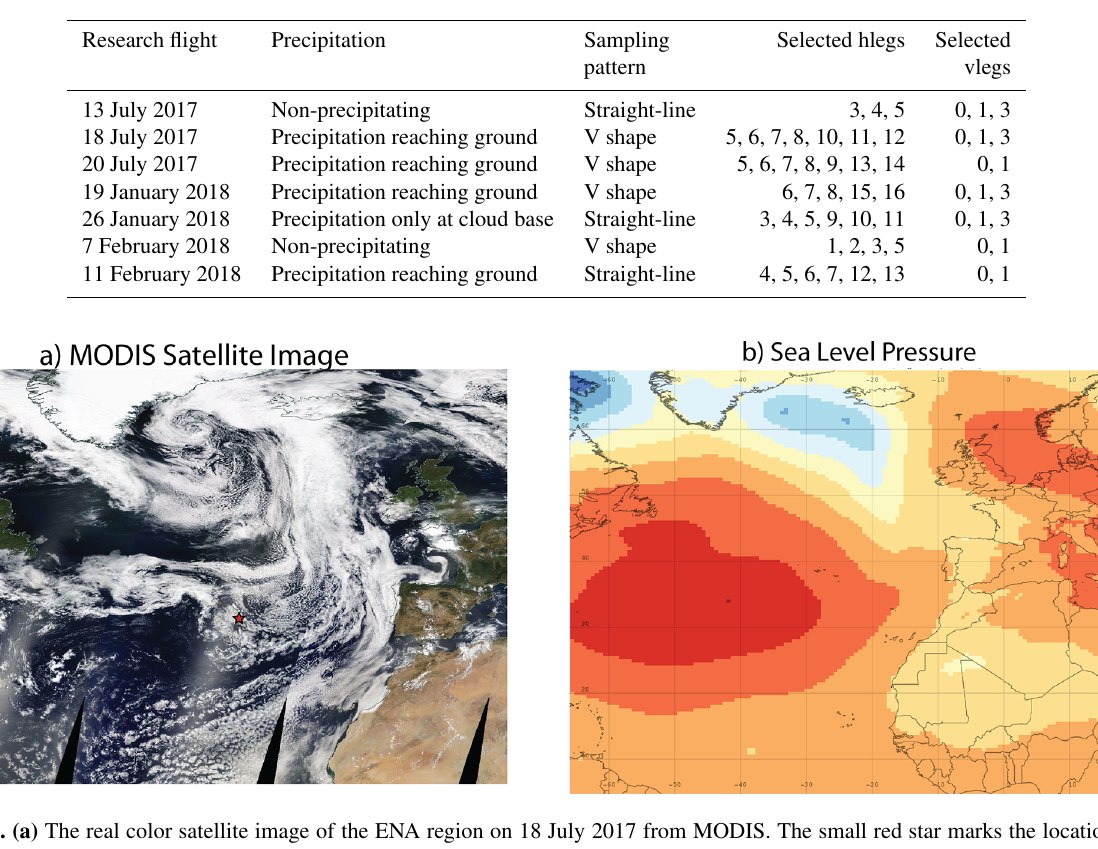
Table 3. A summary of selected RFs and the selected hlegs and vlegs within each RF.